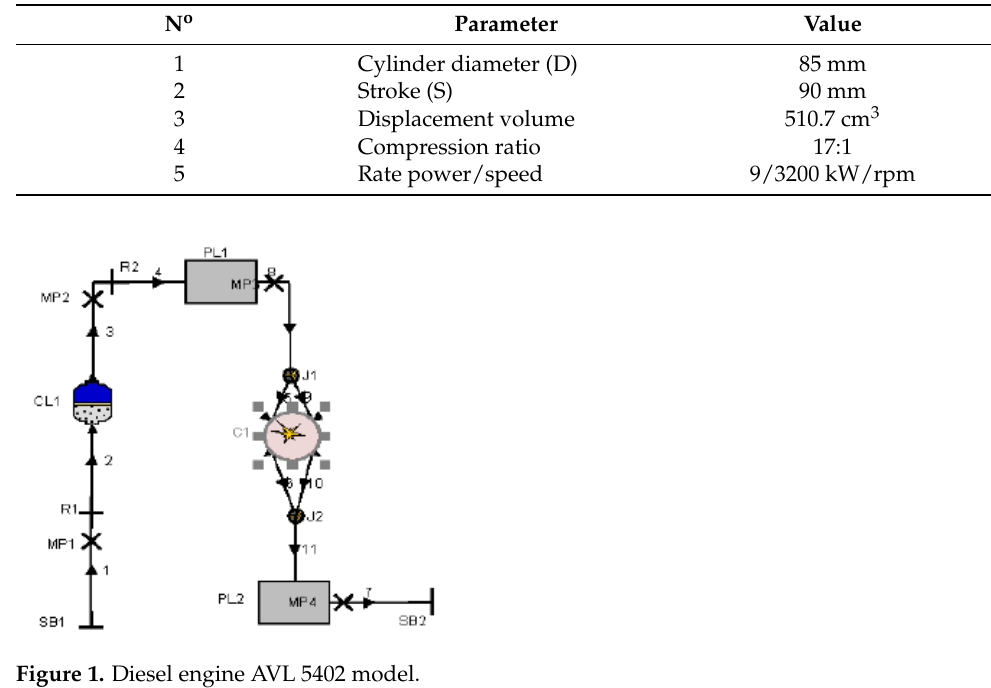
Table 4. Chemical composition of fuel B100.